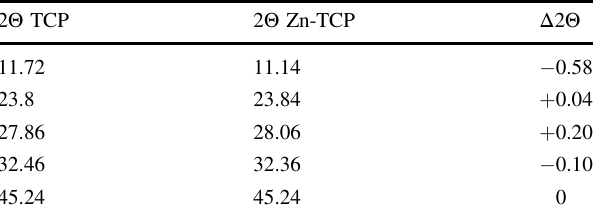
Table 1 Peak position and the corresponding shift of experimental diffraction patterns of β -TCP and Zn- β -TCP powders 2 Θ